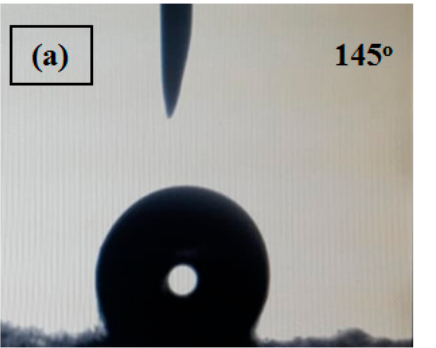
Figure 2. Contact angle of ( a ) PS and ( b ) PS/MWCNTs membranes.